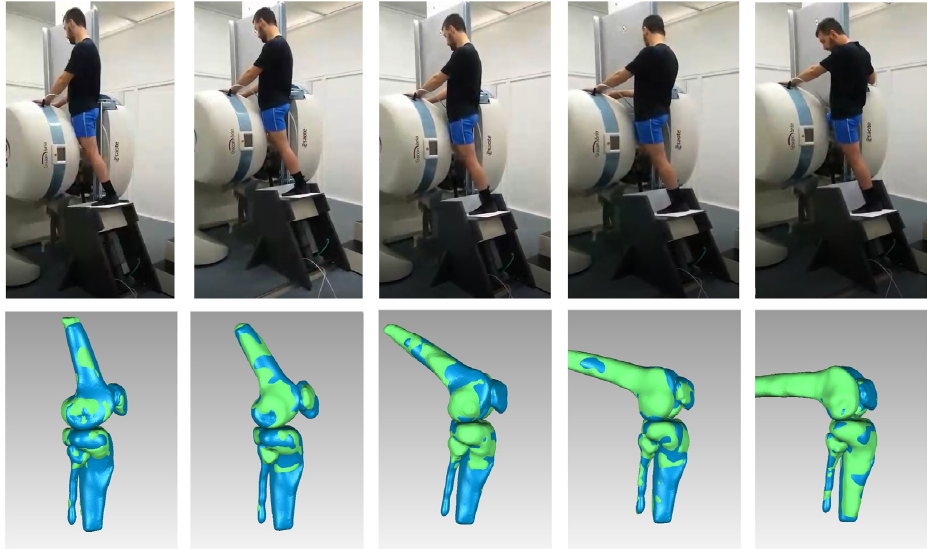
Figure 4. Reconstruction of knee kinematics from five static scans at different knee flexion angles: patient position for each scan ( top row ) and corresponding segmentation of knee bones ( bottom row ). The bones from non-weight-bearing scan are represented in green, registered on the corresponding bones, as segmented from each weight-bearing MRI, in blue.